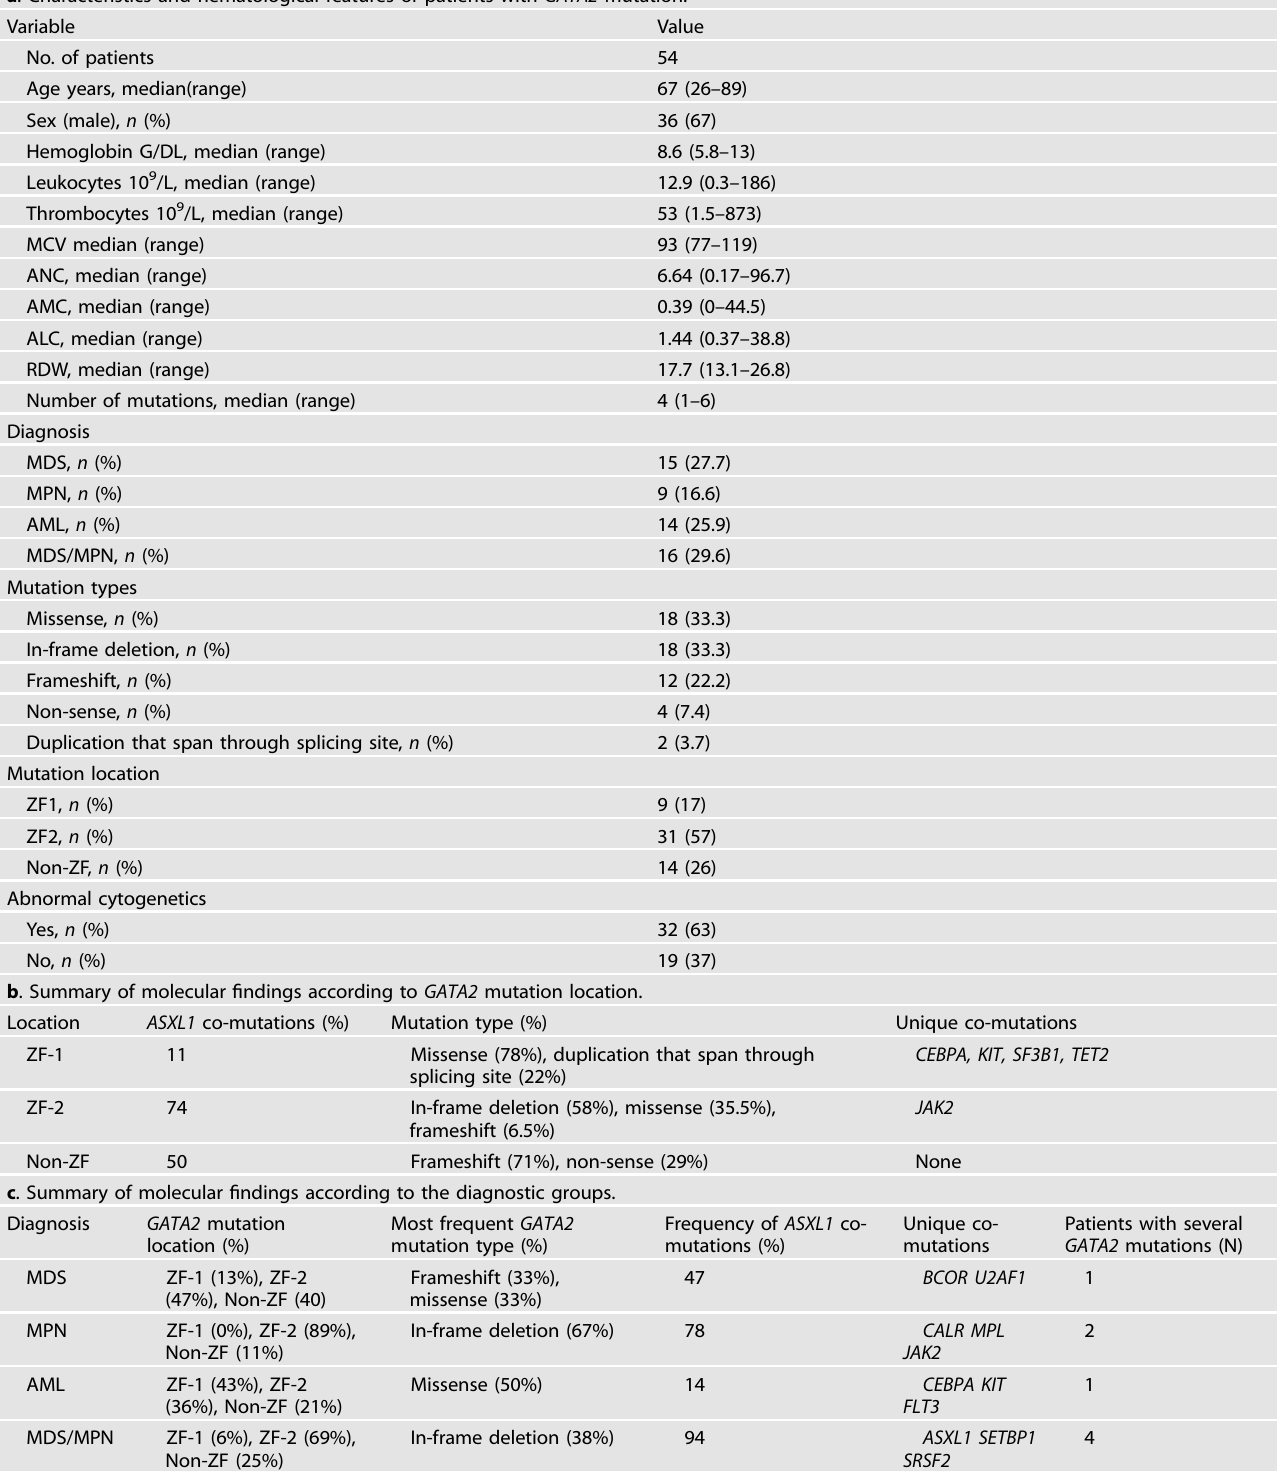
Table 1. Patients characteristics with GATA2 mutation. a . Characteristics and hematological features of patients with GATA2 mutation.